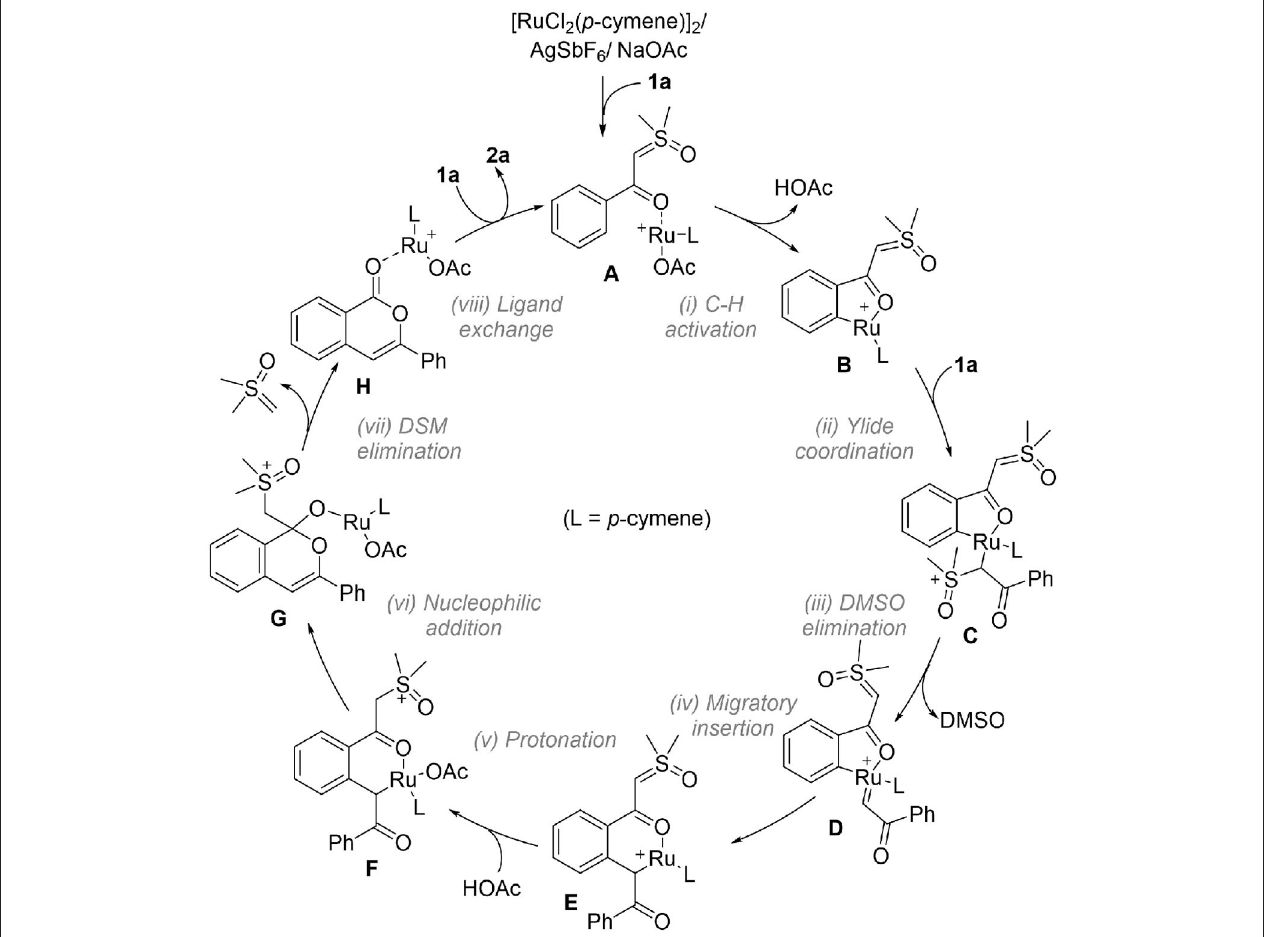
FIGURE 4 | Proposed catalytic cycle based on DFT